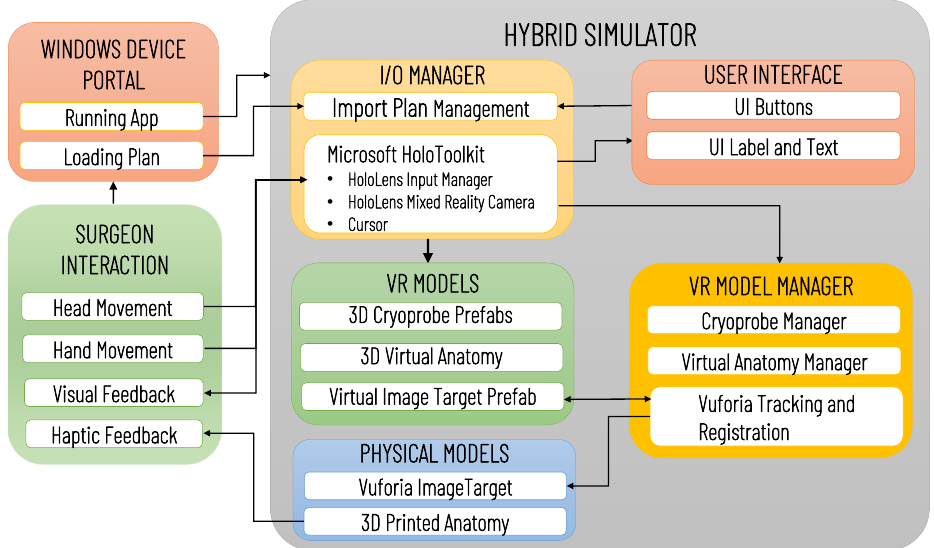
Figure 6. Architecture of the Mixed Reality Simulation Environment developed for Microsoft HoloLens. The diagram illustrates the main software (IO/Manager, User Interface, VR Models, VR Manager) and hardware (Physical Models) modules, the data transfers between modules, and the possible user (surgeon) interactions.